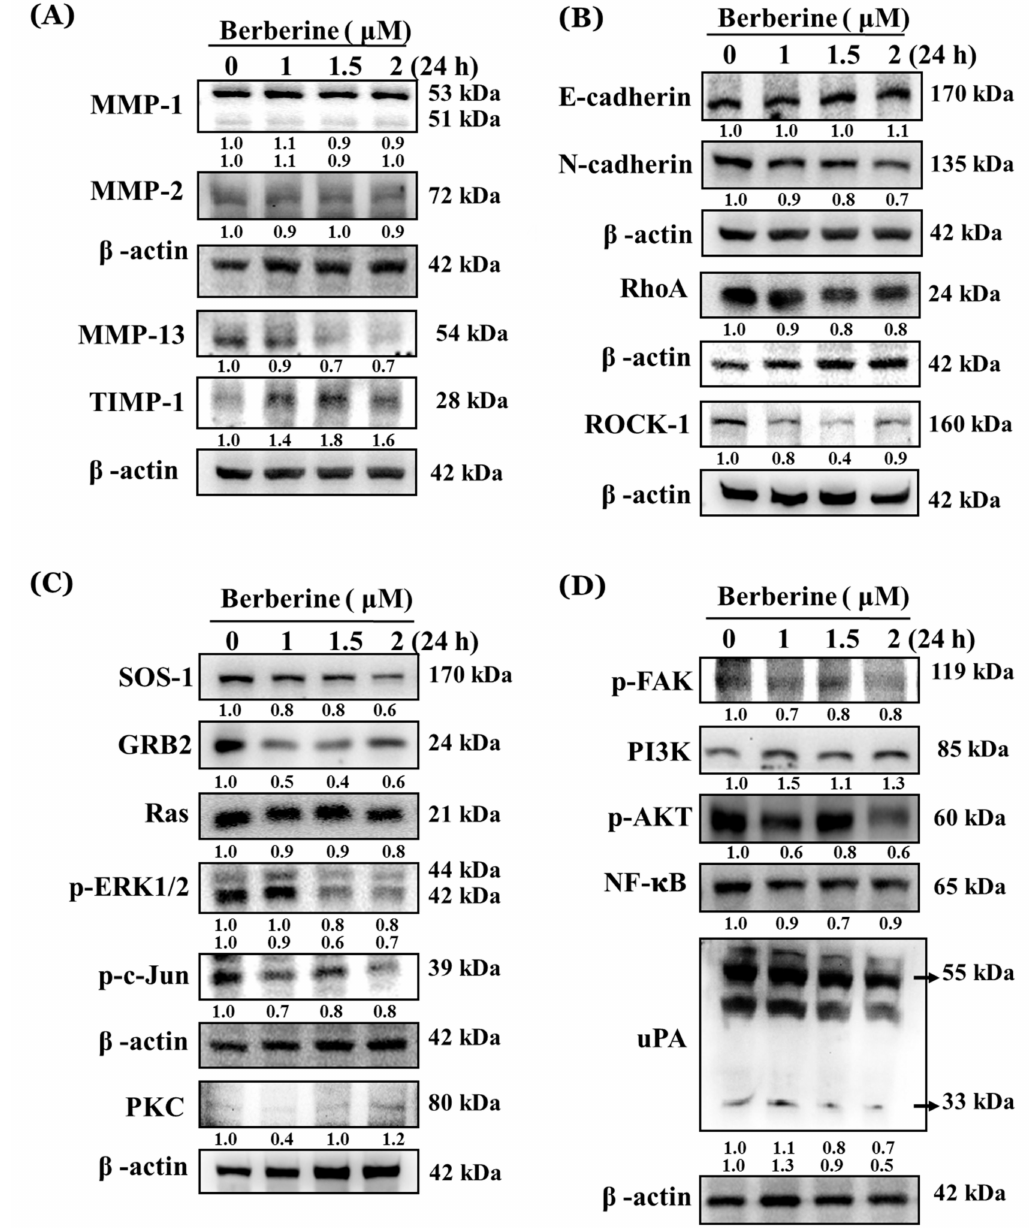
Figure 4. Berberine affected the levels of the associated proteins in the migration and invasion of A375.S2 cells. The cells (1 × 10 6 cells/dish) were treated with berberine (0, 1, 1.5, and 2 µ M) for 24 h. The cells were collected and the total protein was determined for sodium dodecyl sulfate polyacrylamide gel electrophoresis (SDS page) as described in the Materials and Methods. The levels of MMP-1, MMP-2, MMP-13, and TIMP-1 ( A ); E-cadherin, N-cadherin, RhoA, and ROCK1 ( B ); SOS-1, GRB2, Ras, p-ERK1/2, p-c-Jun, and PKC ( C ); p-FAK, PI3K, p-AKT, NF- κ B, and uPA ( D ) expressions were estimated by western blotting as described in the Materials and